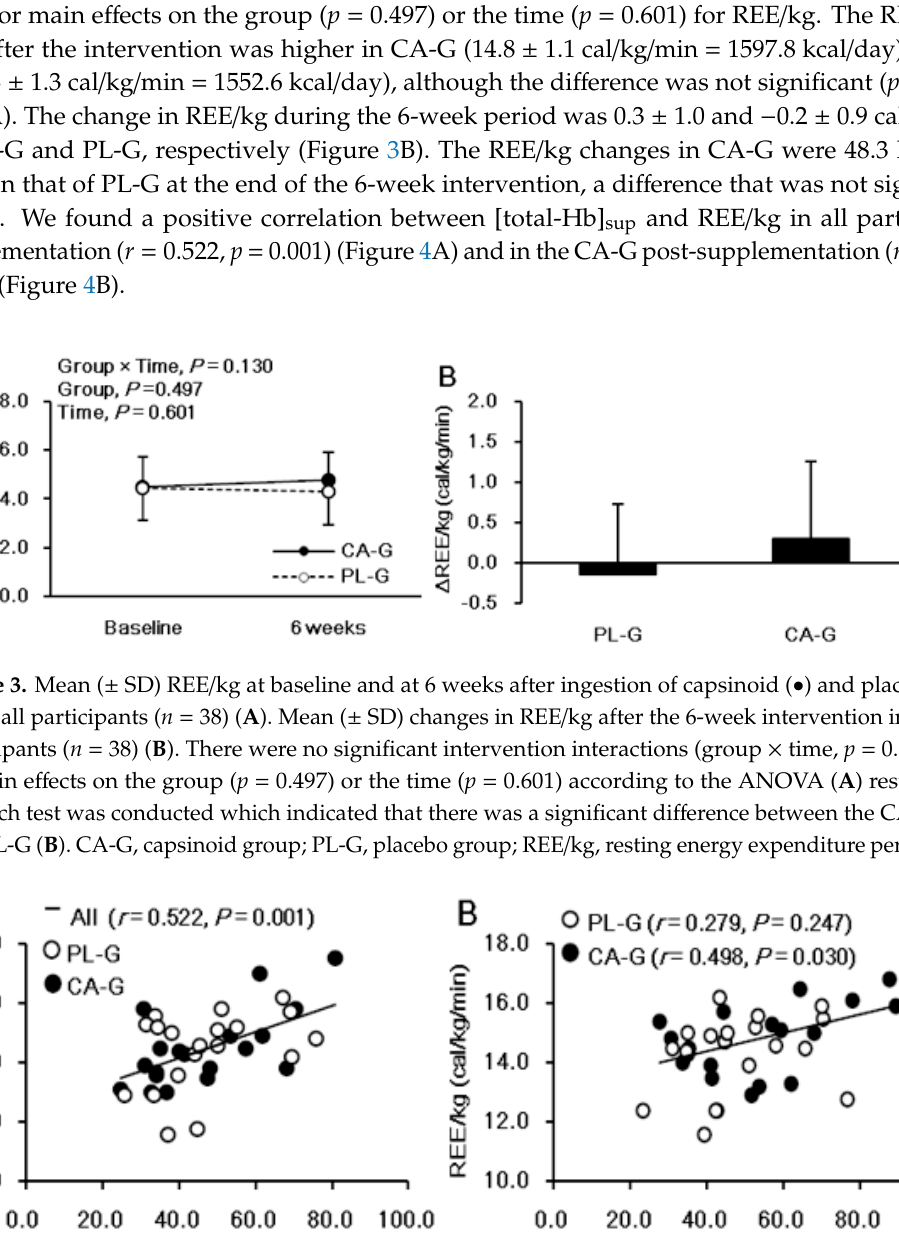
Figure3showstheanalysisofREE / kg. Therewerenosignificantinterventioninteractions(group × time, p = 0.130) or main e ff ects on the group ( p = 0.497) or the time ( p = 0.601) for REE / kg. The REE / kg at 6 weeks after the intervention was higher in CA-G (14.8 ± 1.1 cal / kg / min = 1597.8 kcal / day) than in